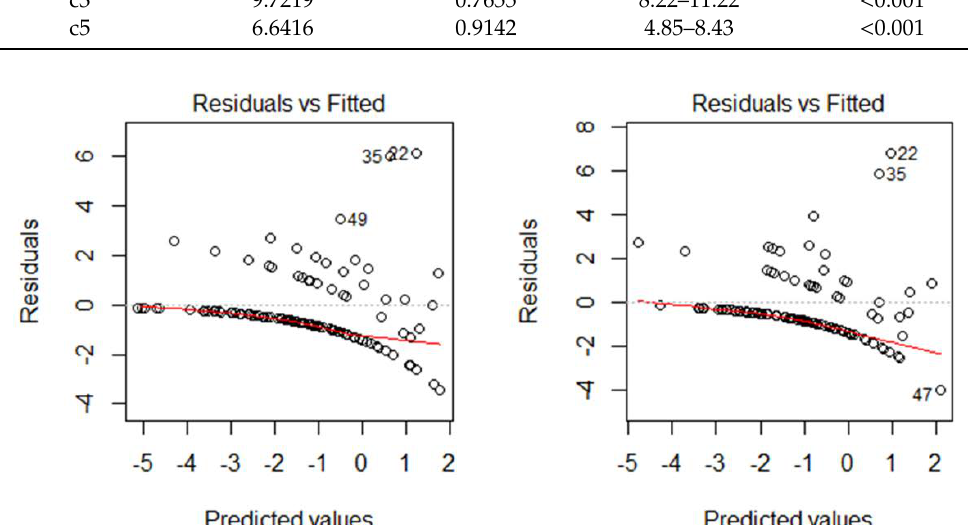
Figure 2. The Residuals vs. Fitted (Predicted) value plots of GLM Model 2 and Model 3.